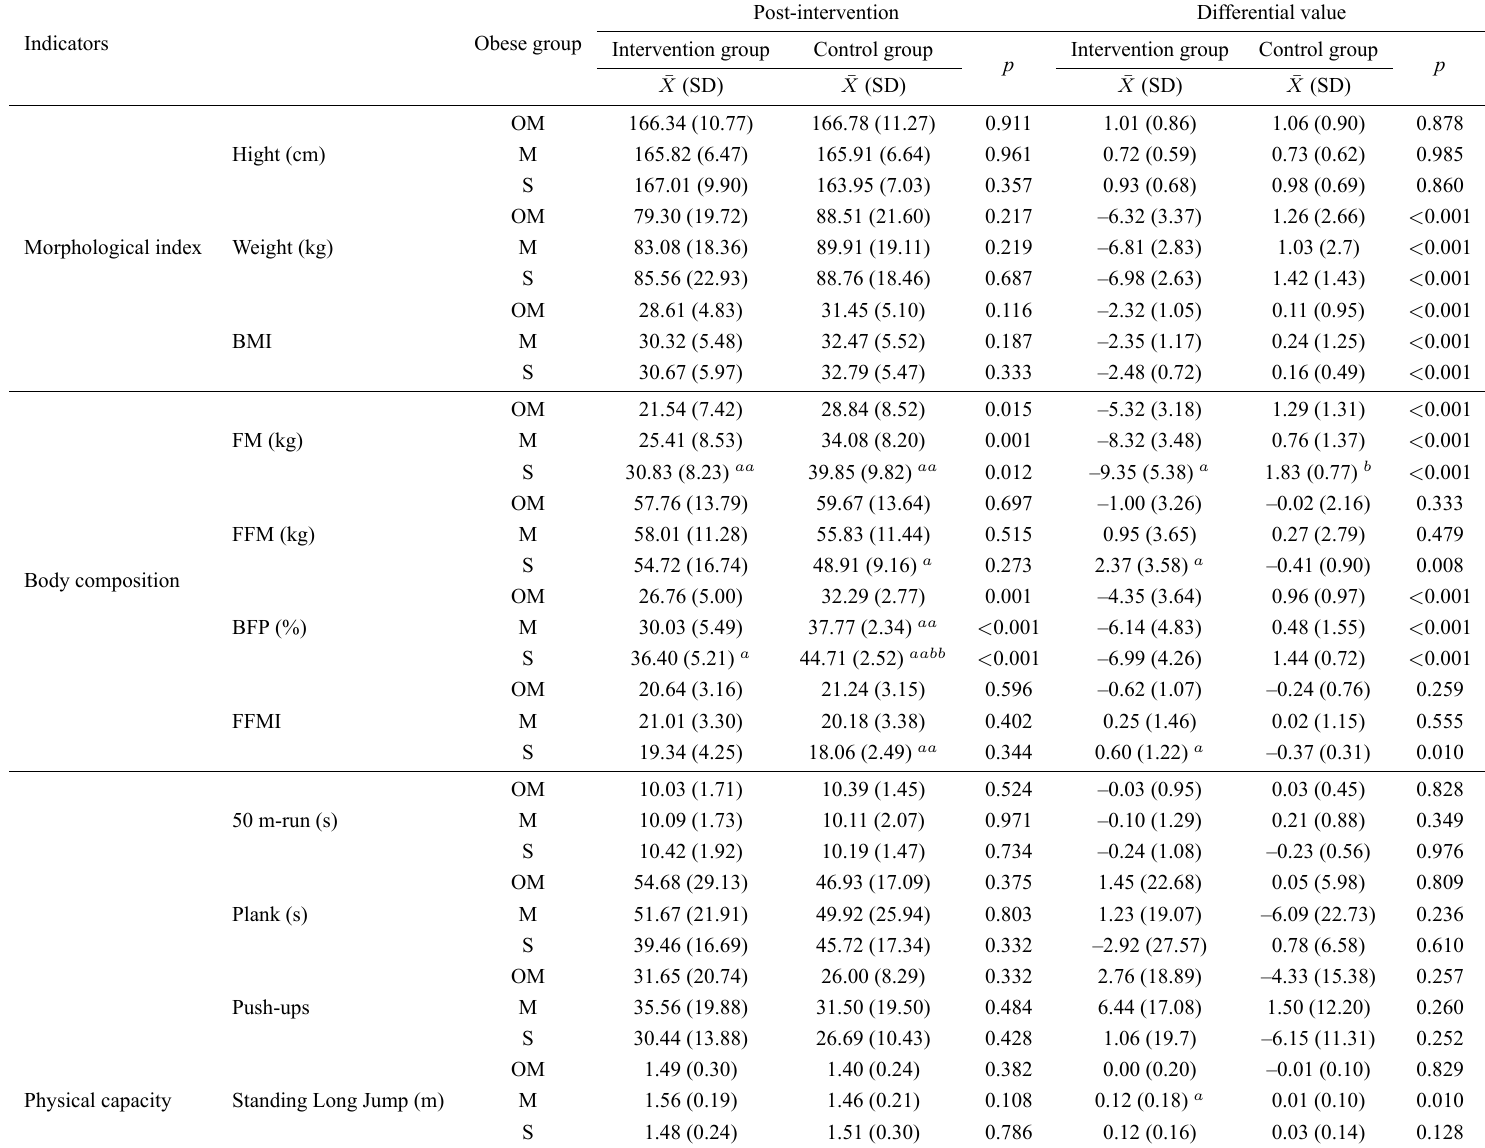
Table 2. Post-intervention test and its difference from baseline